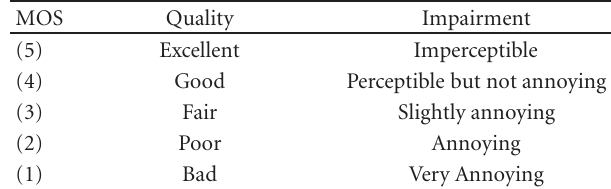
Table 1: Mean opinion score (MOS)